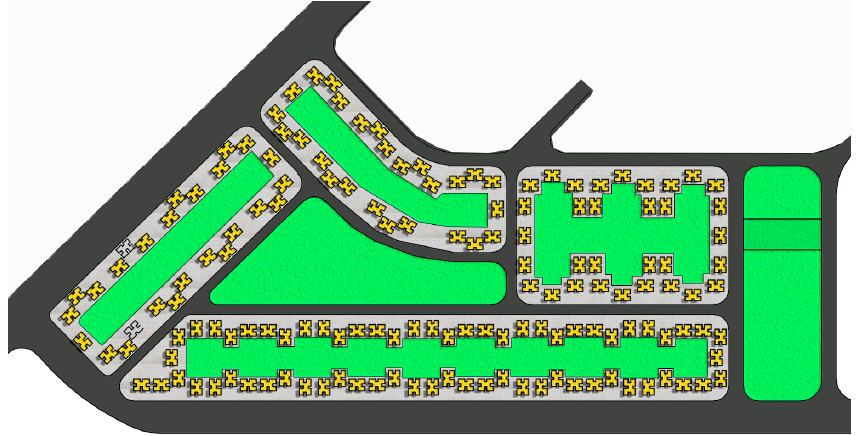
Figure 8. The proposed design for the selected neighborhood at Salam New City. Source: Proposed by the researchers according to the simulation results and analysis.